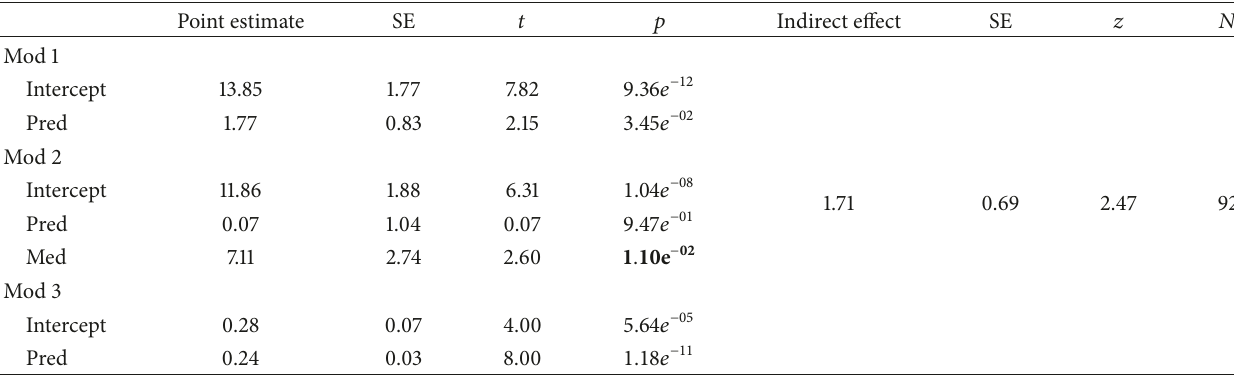
Table 4: Mediation analysis of the directional similarity as mediator of the relationship between simplicity of information structure and task completion time.